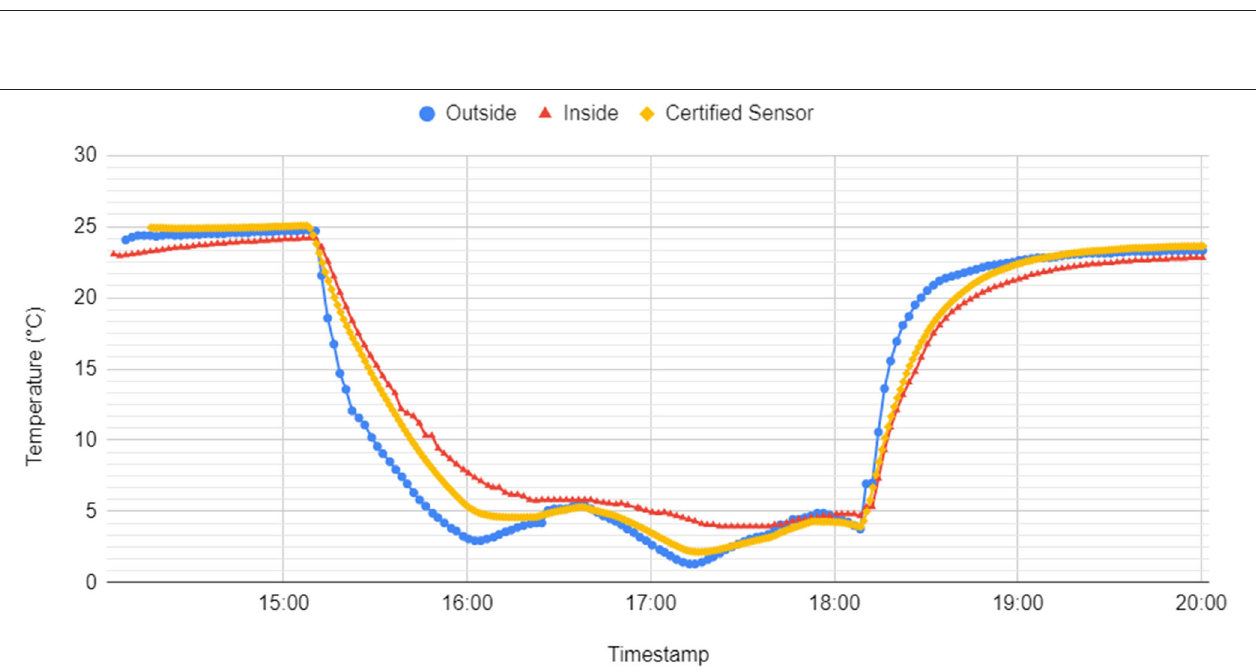
FIGURE 11 | A comparison of temperature between readings from IoT monitors with the sensing probe placed on the inside and on the outside of a delivery box and from certified temperature sensor placed on the outside.